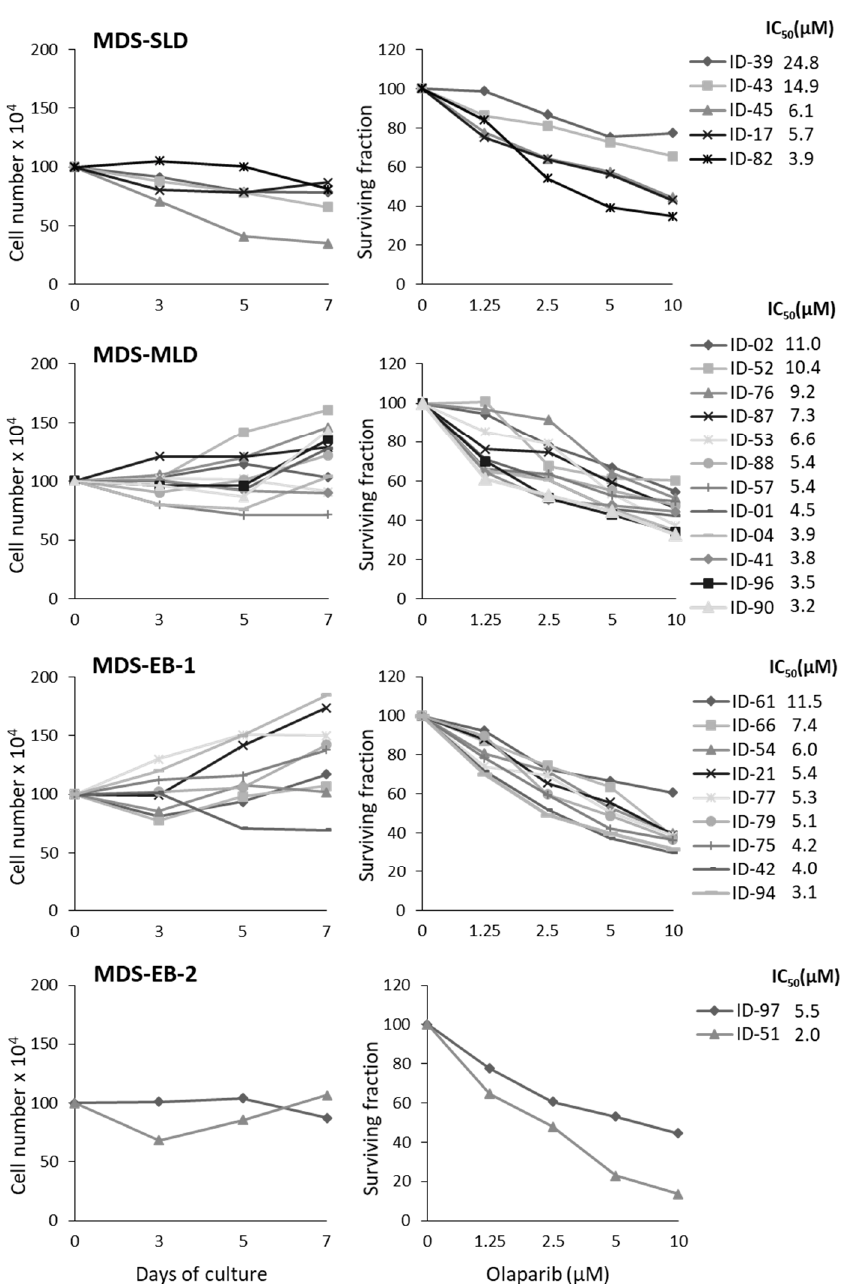
Figure 1. Olaparib exerts cytotoxic effects in primary MDS cultures. BM-MNC collected from MDS patients were cultured with IL-3, SCF and FLT3LG and treated (time 0) with increasing concentrations of olaparib. For each primary culture, cell proliferation was evaluated by counting viable cells using trypan blue exclusion at 3, 5 and 7 days. Standard deviation (SD) of four replicate counts was ≤ 20% and is not shown in the figure. MDS samples were grouped according to morphology, as MDS-SLD, MDS-MLD, MDS-EB-1 and MDS-EB-2. Left graphs represent the proliferation pattern of untreated primary MDS cells during 7 days of culture. Right graphs show the surviving fractions after 7 days of treatment, and the olaparib IC 50 s for each sample calculated with respect to untreated cells cultured for the same time period.